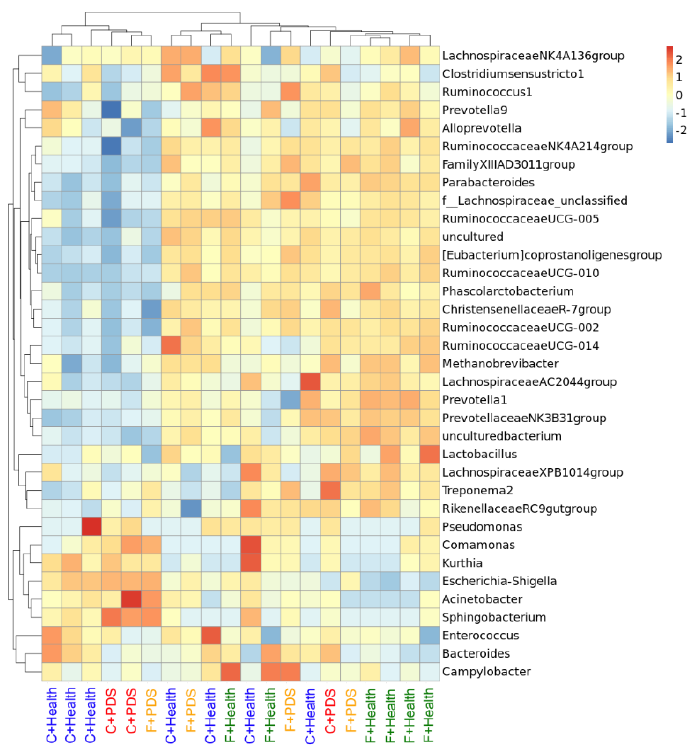
Figure 3. Species abundance heat map showing normalized values of 35 di ff erentially abundant genera of four groups. Group and genus names are plotted on the X -axis and Y -axis, respectively. Red color indicates that the Z-score of a specific genus is larger than the mean, whereas the blue color indicates the